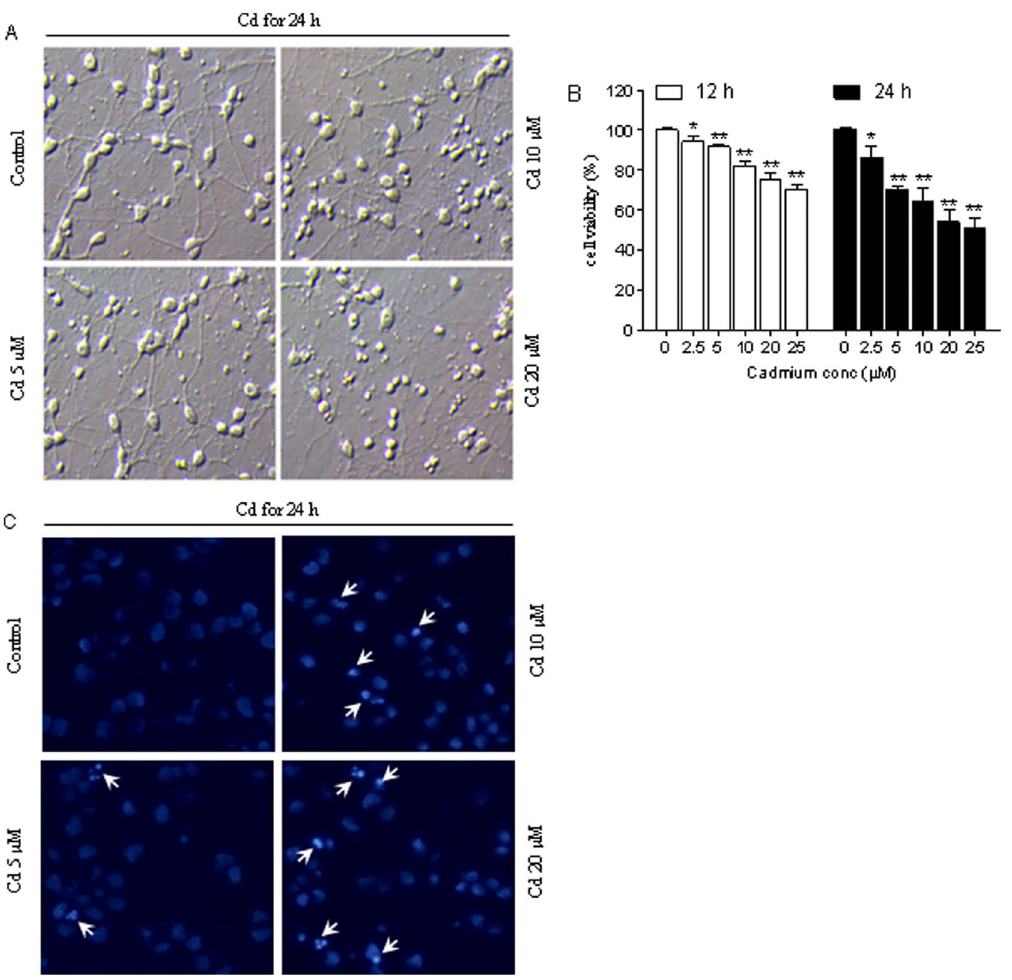
Figure 1. Cd induces apoptosis in cerebral cortical neurons. (A) Morphological alterations in cerebral cortical neurons treated with different concentrations of Cd (0, 5, 10 and 20 m M) for 24 h. Cell morphology was assessed using a LEICA inverted phase-contrast microscope (400 6 ) equipped with Quick Imaging system. All experiments were performed in duplicate. (B) Cell viability of cerebral cortical neurons, treated with 0–25 m M Cd for 12 and 24 h, was evaluated by MTT assay. Results are presented as mean 6 SD (n=6). *Statistical significance between control and Cd treatment (2.5, 5, 10, 20 and 25 m M); * P , 0.05, ** P , 0.01 compared to respective control, using Student’s t-test. (C) Cd induced apoptotic morphological changes in cerebral cortical neurons. Cerebral cortical neurons were incubated with 0–20 m M Cd for 24 h, stained with Hoechst 33258. Cell morphology was analyzed by fluorescence microscopy (arrows, apoptotic cells). The original magnification is 400 6 . All experiments were performed in duplicate.